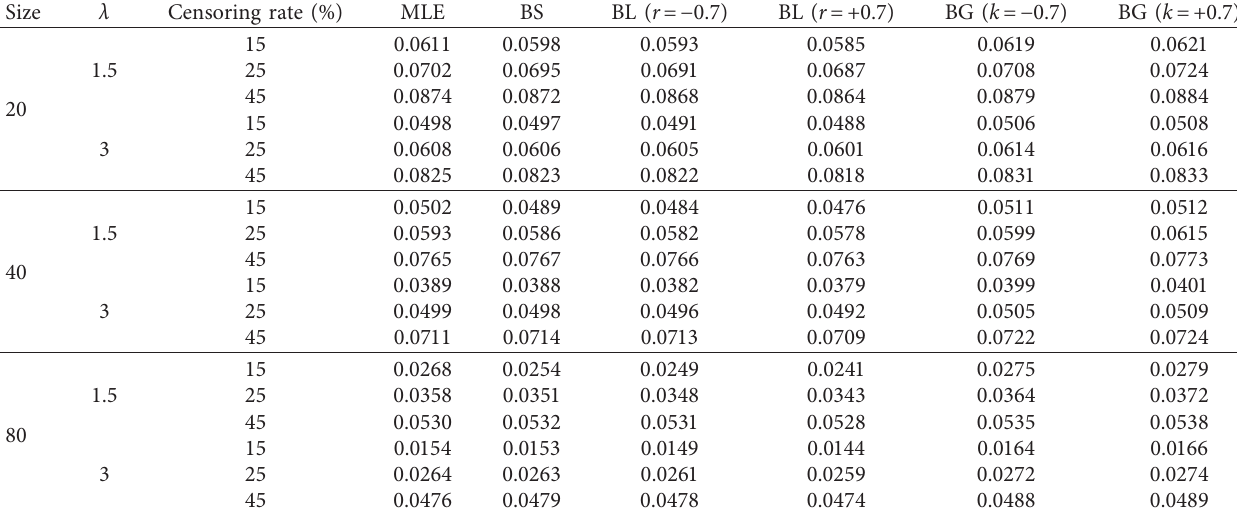
Table 5: MSE estimations of the survival